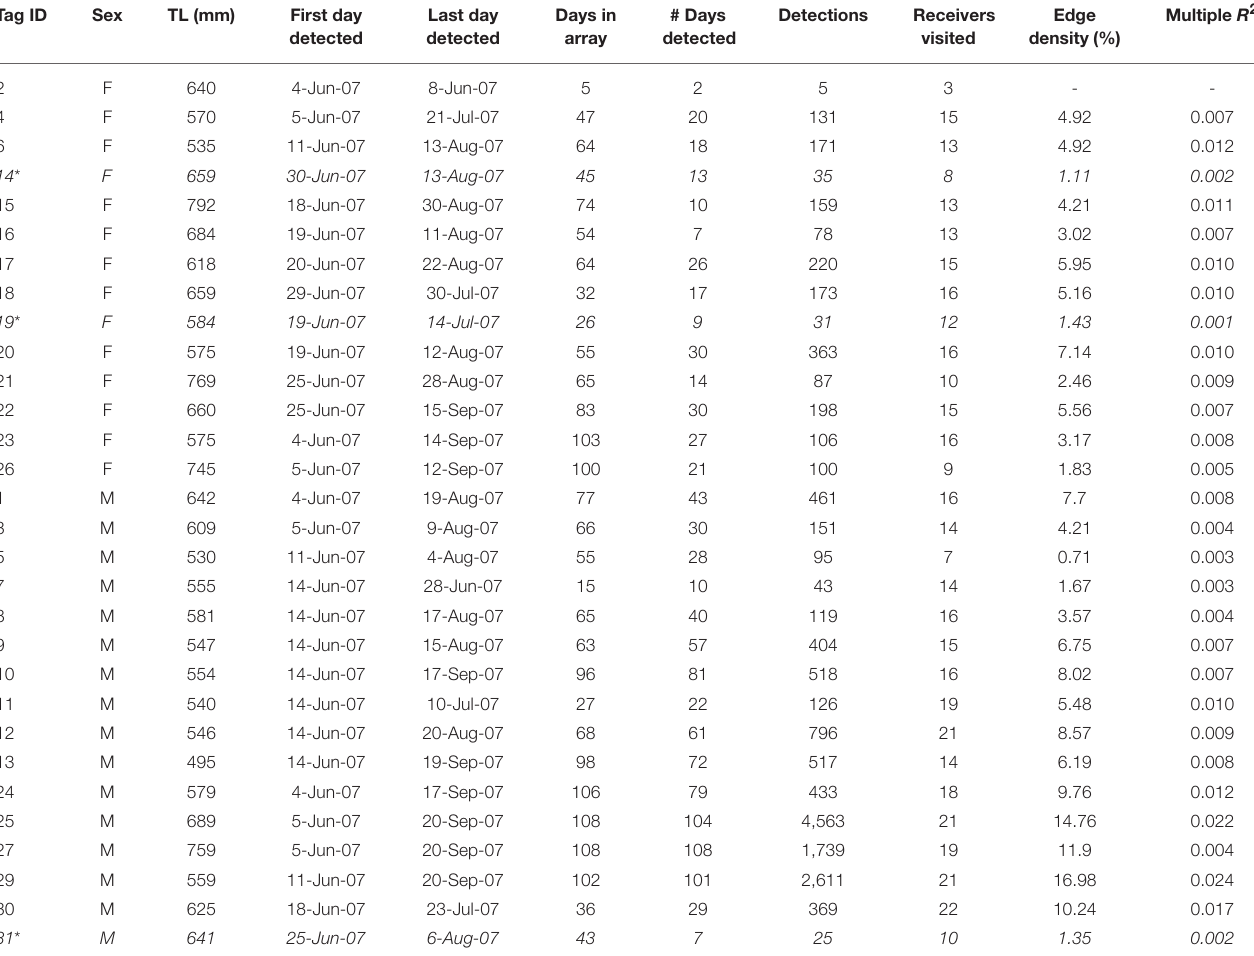
TABLE A1 | Summary of movement data and spatial network metrics for individual C. undecimalis tagged with acoustic telemetry transmitters ( n = 30) in Tampa